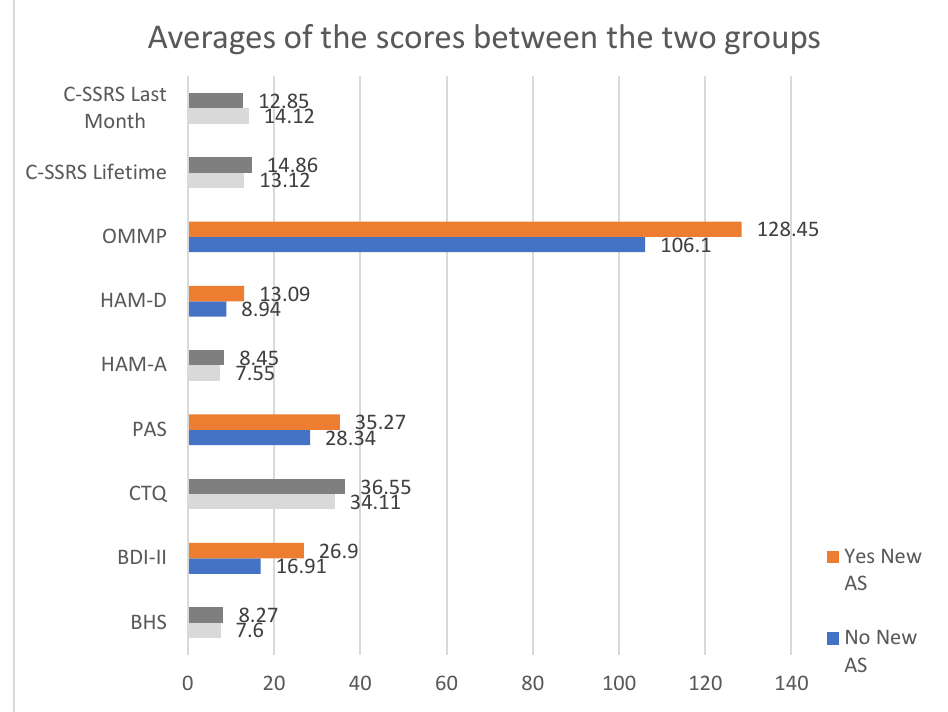
Figure 1. Averages of the psychometric scales’ scores associated with the risk of new AS. Grayed out—the insignificant scores; colored out—the scores with p value < 0.05.